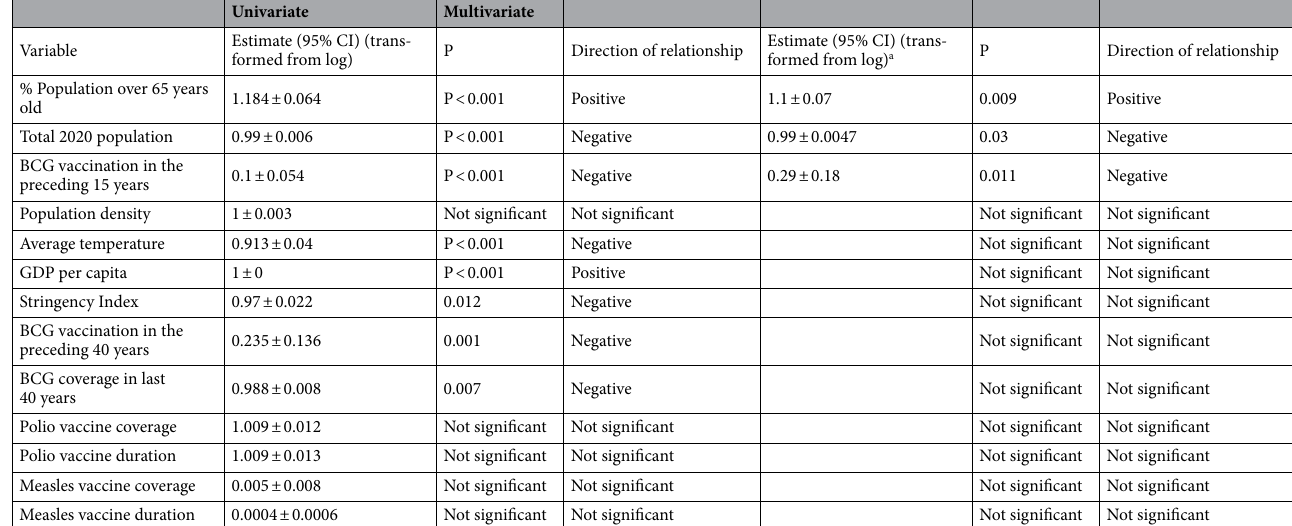
Table 2. Results of linear regression analysis. The percentage of the population over 65 years of age was associated with higher rates of CRM such that for every percent increase in population over 65 years old, CRM increased by 10% (95% confidence interval 2–18%). The total population of a country was associated with improved CRM (for every unit increase there was a 1% decrease in CRM (95% CI 0.53–1.47%). An active BCG vaccination program for the preceding 15 years was shown to reduce CRM significantly by 71% (95% CI 53–89%). A negative relationship suggests that the variable results in a decrease in CRM and vice versa. a The antilog of all estimates. For example, when % population above 65 yrs. increases by 1%, the deaths/mn on an average increase by 1.10 times, i.e., 10% (with a 95% CI of 1.02–1.18 or 2–18%). Likewise, when a country has BCG coverage in the last 15 years, the deaths/mn decreases by 0.29 times, i.e., 71% (with a 95% CI of 0.11–0.47 or 89–53%).